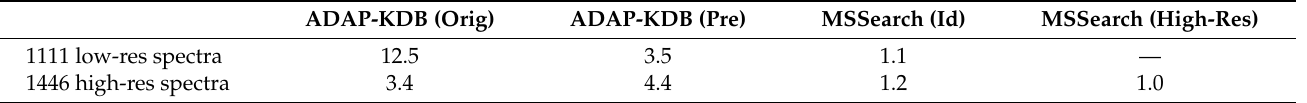
Table 1. Average execution time of each spectral search per spectrum (in seconds). The columns (from left to right) correspond to the original ADAP-KDB spectral search, new ADAP-KDB spectral search with prescreening, the NIST MSSearch identity search for low-resolution spectra, the NIST MSSearch in-source HighRes similarity search.